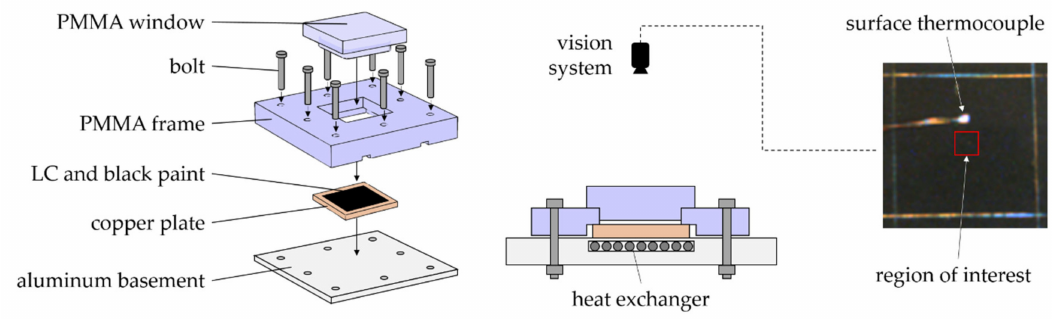
Figure 8. Sketch of the facility for the calibration through the temperature evolution